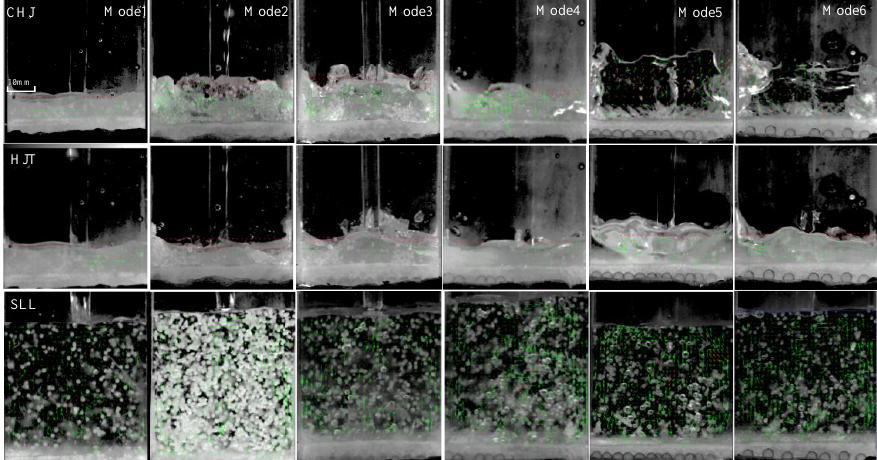
Figure 4. Hydraulic jump form and flow field in three physical forms of hydraulic jump of front view (casting speed of 2.4 m/min, mode 1 – 6).